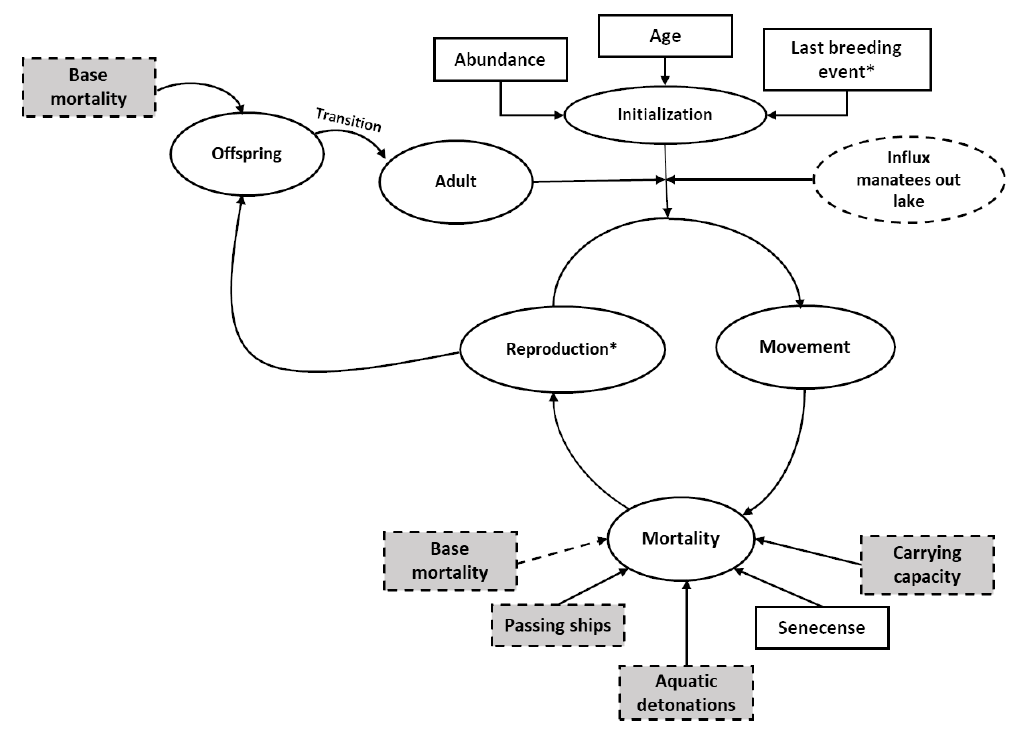
Figure 3. Diagram of the individual-based model (IBM). The diagram represents the sequence of the population dynamics included in IBM. Dashed lines indicate a process that can be adjusted or turned off; * indicates processes that are only part of the female breeding process. Initializaiton indicates the start or first run of the model for a particular scenario.